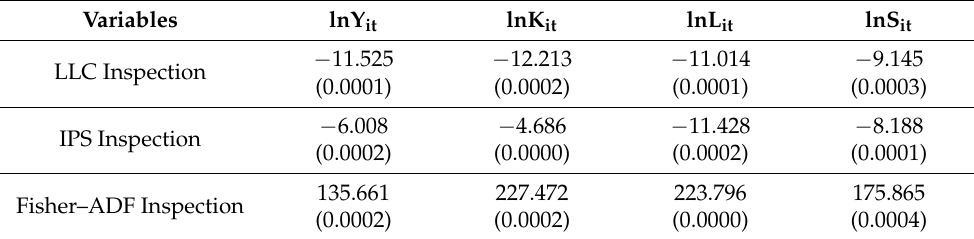
Table 2. Tests for smoothness of